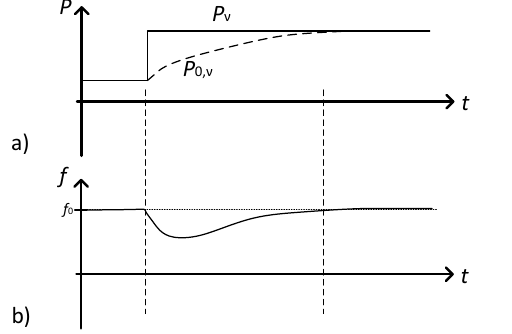
Fig. 2. Primary and secondary control; a) active power and active power setpoint; b) grid frequency.